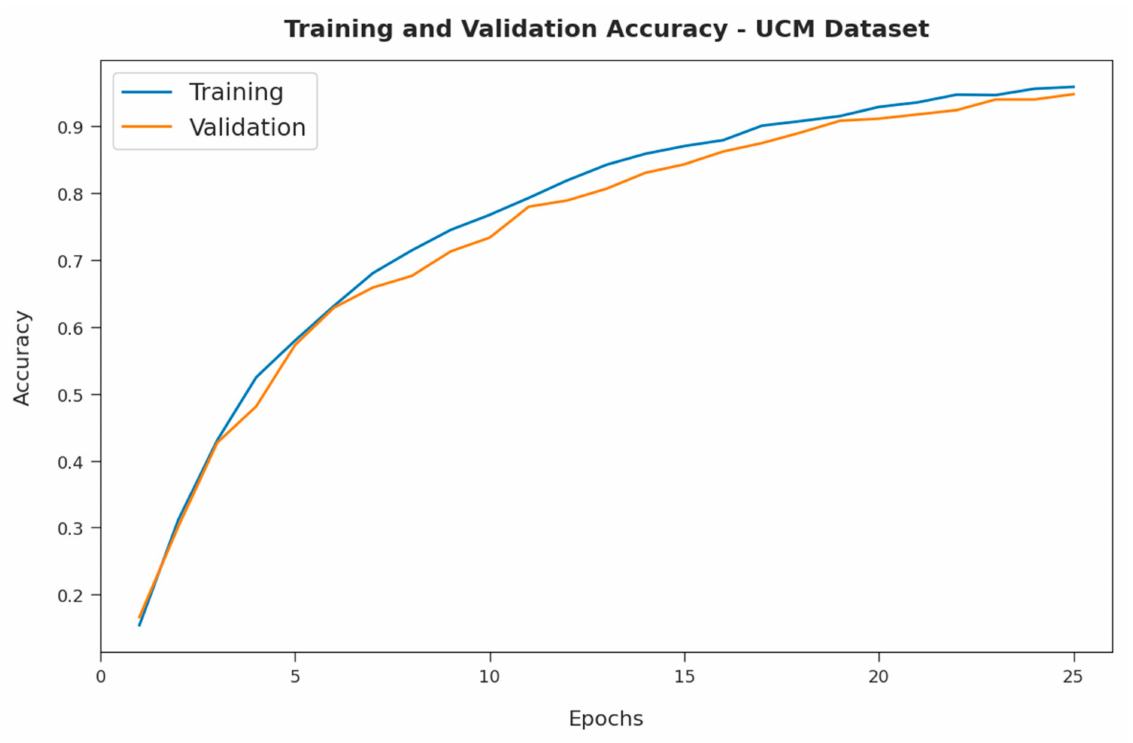
Figure 6. TA and VA analysis of SIDTLD-AIC technique on UCM